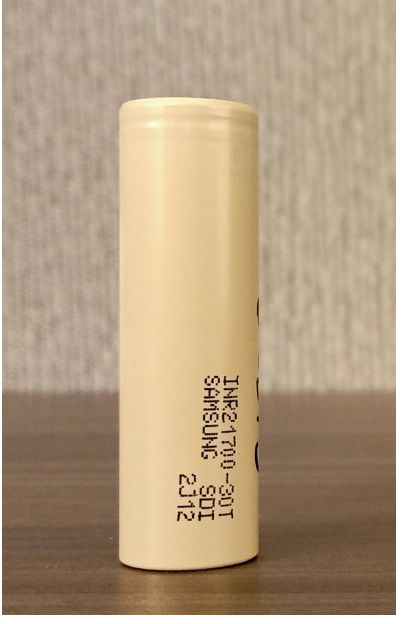
Figure 2. Samsung-30T INR21700 Li-ion battery Table 3. Specifications of Li-ion